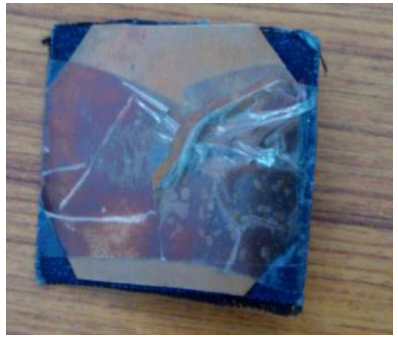
Fig.1.16 Front view of fabricated antenna